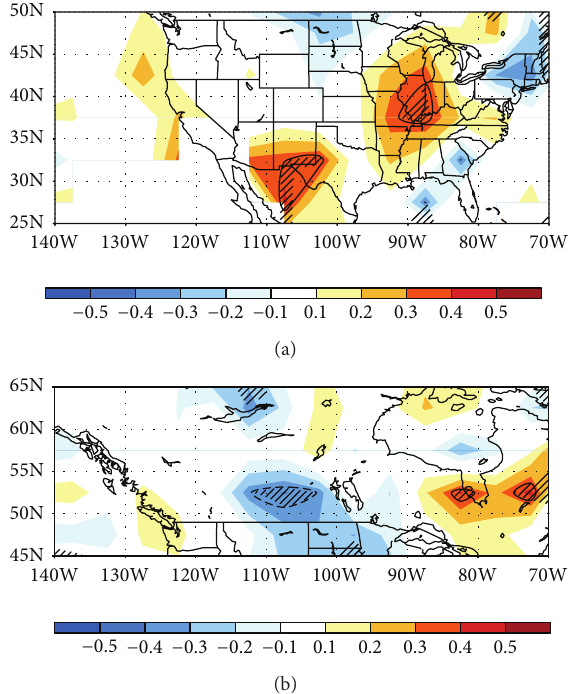
Figure 8: Correlation of storm-rainfall index with storm track fre- quency for (a) AMJ, (b) JAS. Hatched areas show 95% significance.